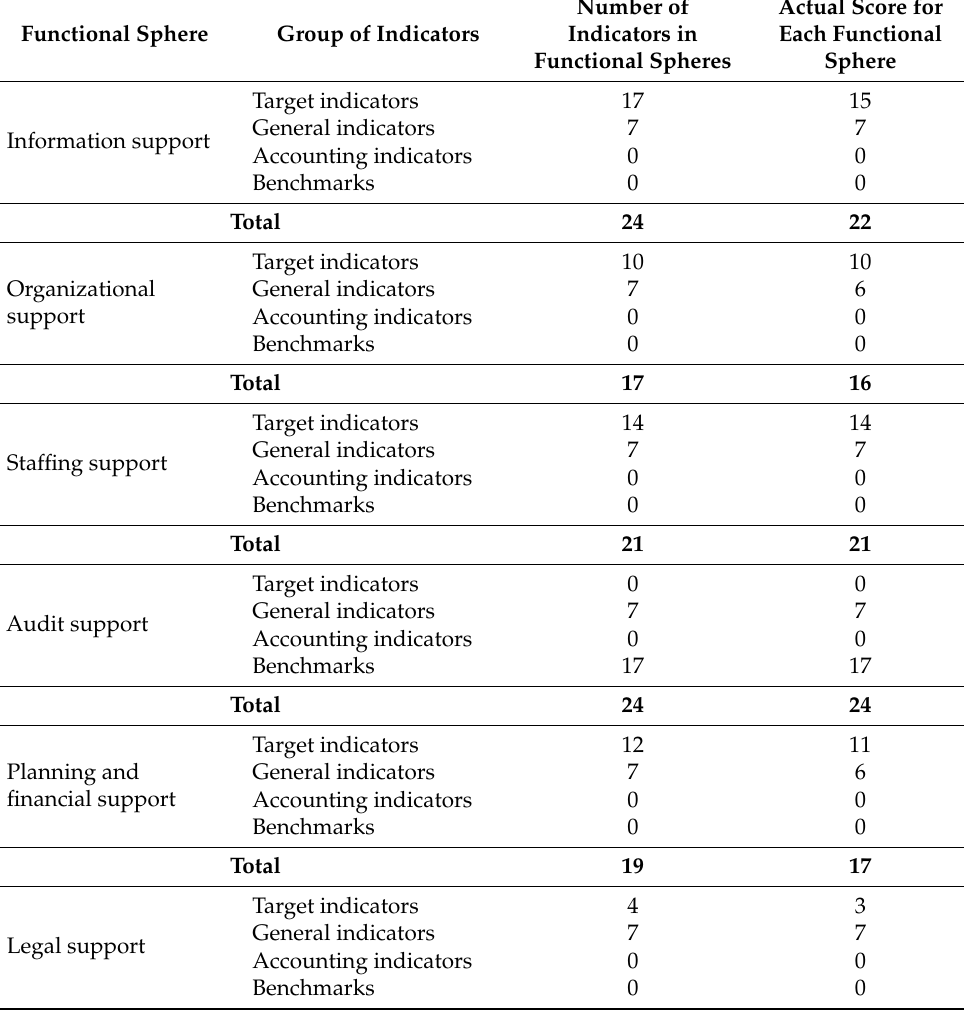
Table 6. The maximum score for functional spheres.